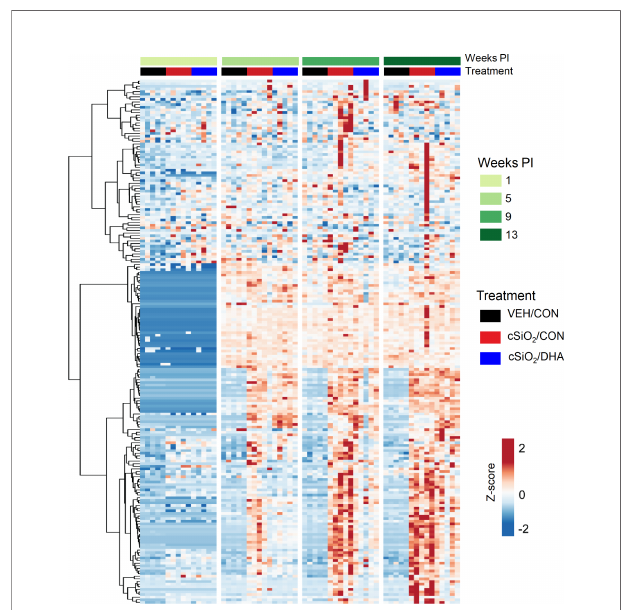
FIGURE 2 | DHA intake modulates cSiO 2 -induced in fl ammatory protein responses in BALF. Heat map with unsupervised clustering (Euclidian distance method) depicting unit variance-scaled mean fl uorescent intensities (MFIs) for 203 proteins. Black, red, and blue bars above the heatmap indicate the VEH/ CON, cSiO 2 /CON, and cSiO 2 /DHA groups, respectively, at 1, 5, 9, or 13 wk